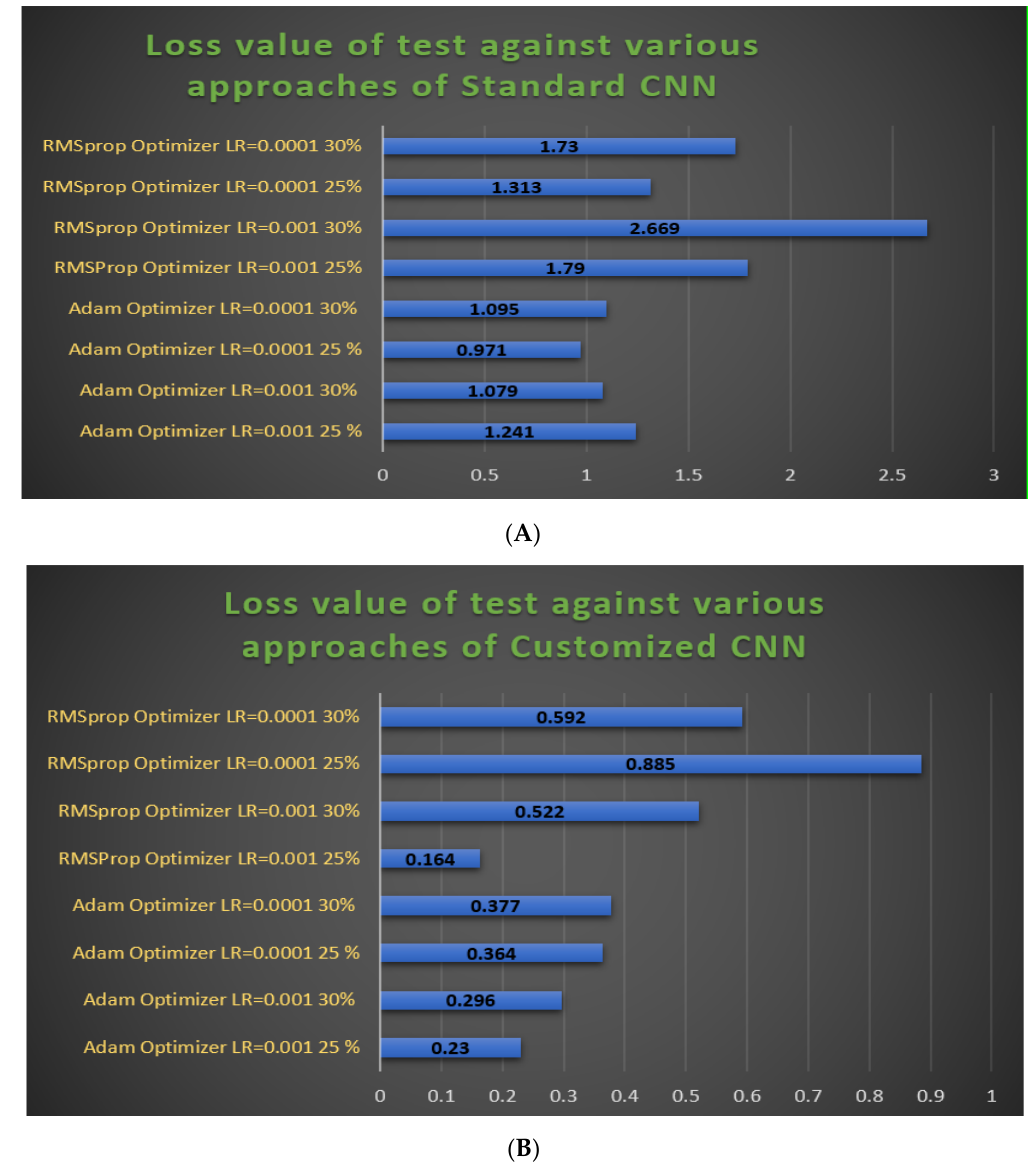
Figure 9. Bar graphs of loss value comparisons of our models. ( A ) The bar graph of the test loss values of eight approaches of the standard CNN model. (B ) The bar graph of the test loss values of eight approaches of the standard CNN model.